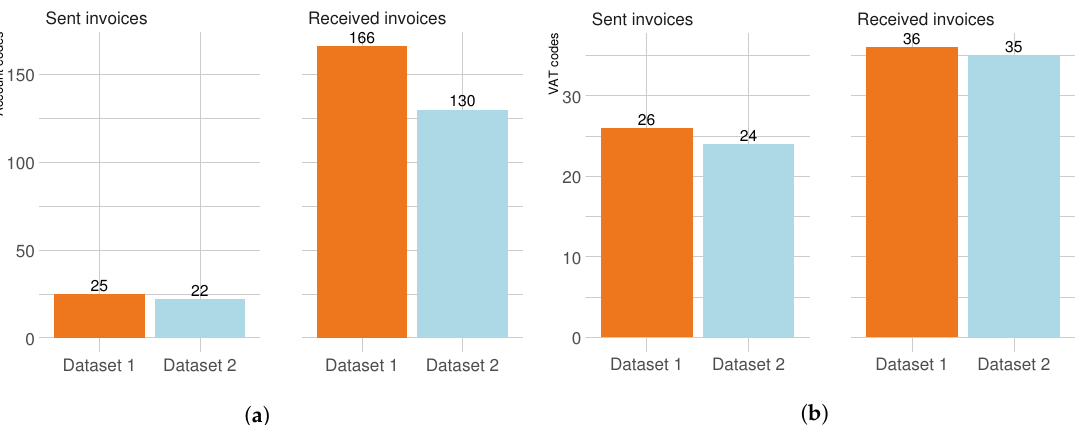
Figure 3. Number of distinct codes used for sent and received invoices in the two datasets analyzed: ( a ) account codes; and ( b ) VAT